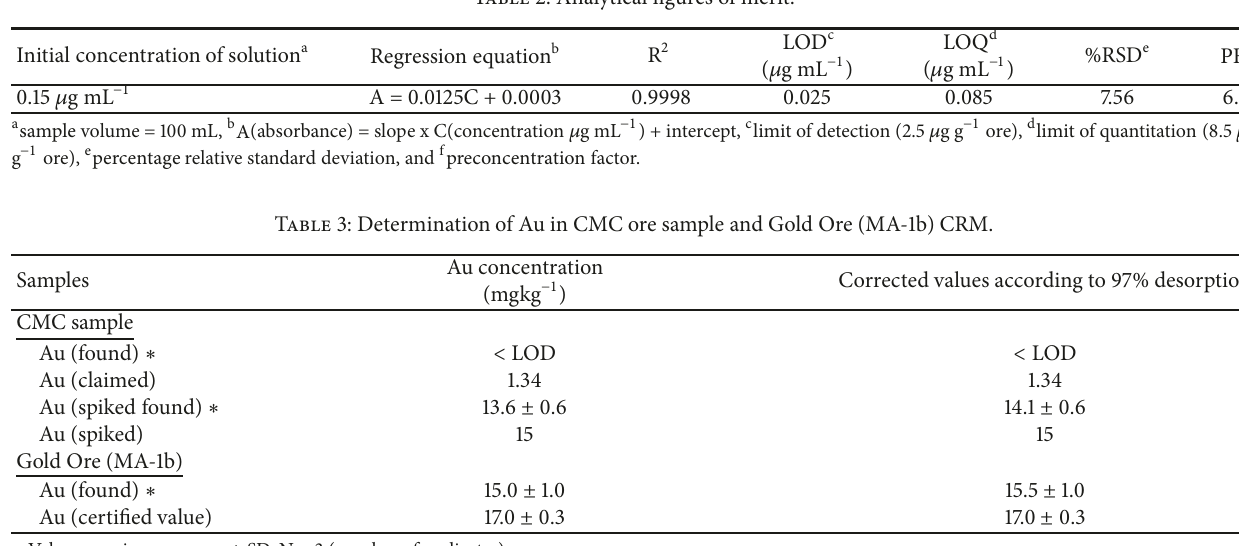
Table 2: Analytical figures of merit.